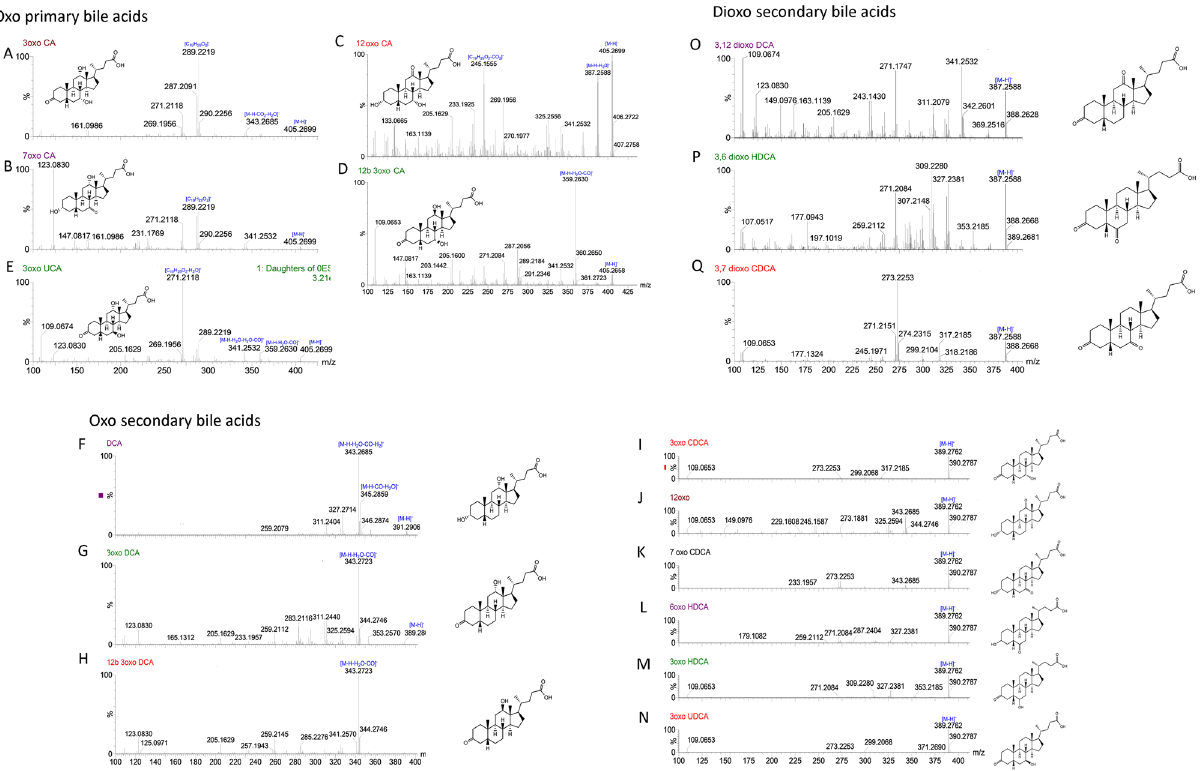
Figure 3. HR tandem MS spectra of the oxo metabolites of bile acids in the investigated